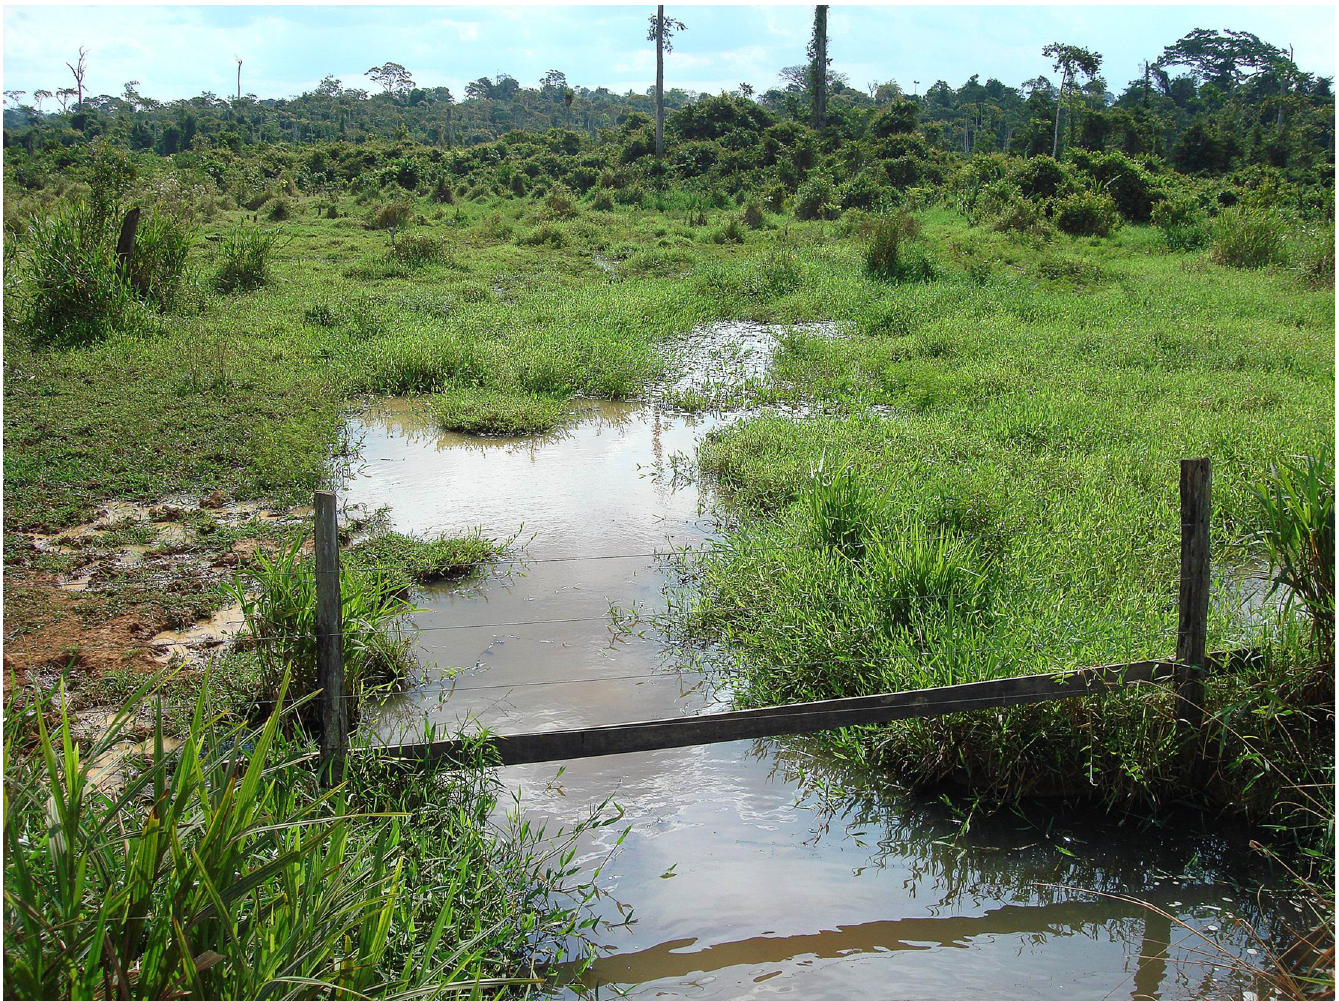
Fig 8. Type locality of Tyttobrycon shibattai . Rio Ina´, tributary of Rio Abun ã , Rio Madeira drainage. Photograph taken in October 2010.